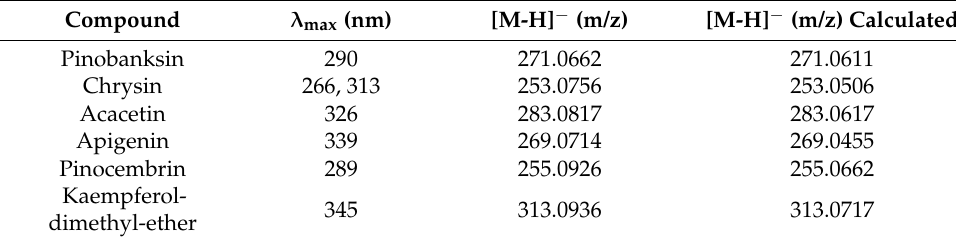
Table 1. Chemical profile as defined by